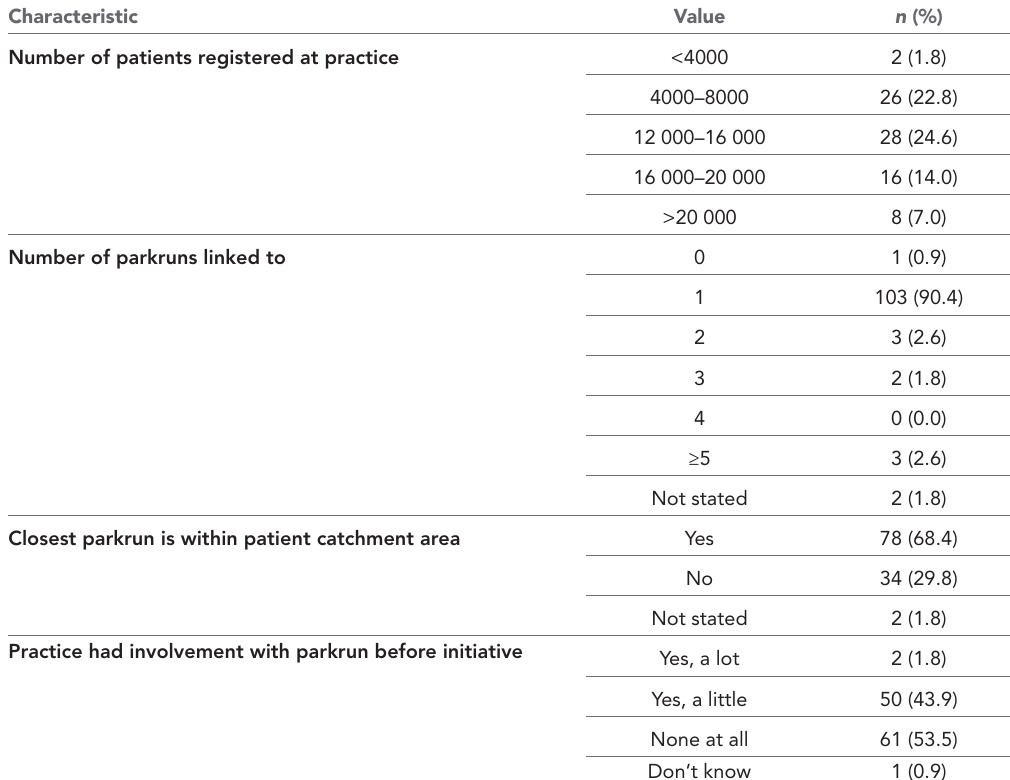
Table 2 Type, location, and frequency of information presented ( N =